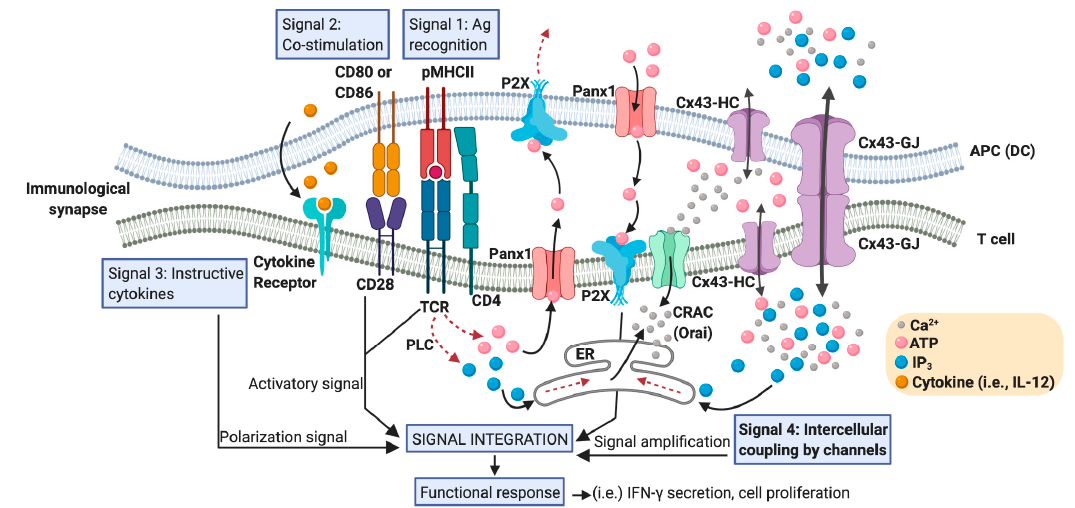
Figure 2. Positioning Cx43 in the intercellular coupling by channels in the DC-T cell IS. An IS between an APC (particularly a DC) and a T cell that e ff ectively promotes T cell activation contains a large number of signaling molecules and signaling events that converge in order to generate T cell functional responses. These signaling events include the activation signal produced by TCR-pMHC ligation (antigen recognition: signal 1), plus co-stimulatory receptor engagement (signal 2), and a polarization signal yielded by instructive cytokines released by the APC (signal 3). Calcium release activated calcium channels (CRAC), such as Orai; hemichannels such as those formed by Panx1 and Cx43; and Cx43 formed gap junctions (Cx43-GJs), are involved in the Ca 2 + - and ATP- (via purinergic P2X receptors) mediated signaling amplification required for antigen-dependent T cell activation. Although Ca 2 + can di ff use through Cx43 channels, the current consensus is that inositol triphosphate (IP 3 ) is the critical intercellular signal that modulates Ca 2 + release from internal cellular stores, like endoplasmic reticulum (ER), and it is responsible for GJ-mediated Ca 2 + waves in other cell models. An increase in the levels of IP 3 in T cells could be produced by the convergence of those generated by phospholipase C (PLC) activation and those acquired from DC via Cx43 (or other Cx isoform) channel-mediated communication. We called these signaling events ‘intercellular coupling by channels’ and considered them as signal 4 in a DC-T cell IS. In response to TCR and CD28 stimulation, Panx1, purinergic P2X receptors, CRAC, and Cx43 translocate to the IS. ATP released through hemichannels promotes autocrine / paracrine signaling via the P2X receptors and the entry of Ca 2 + into T cell. Curved arrows indicate movement of molecules; dotted arrows indicate a signaling pathway; straight arrows connect concepts.